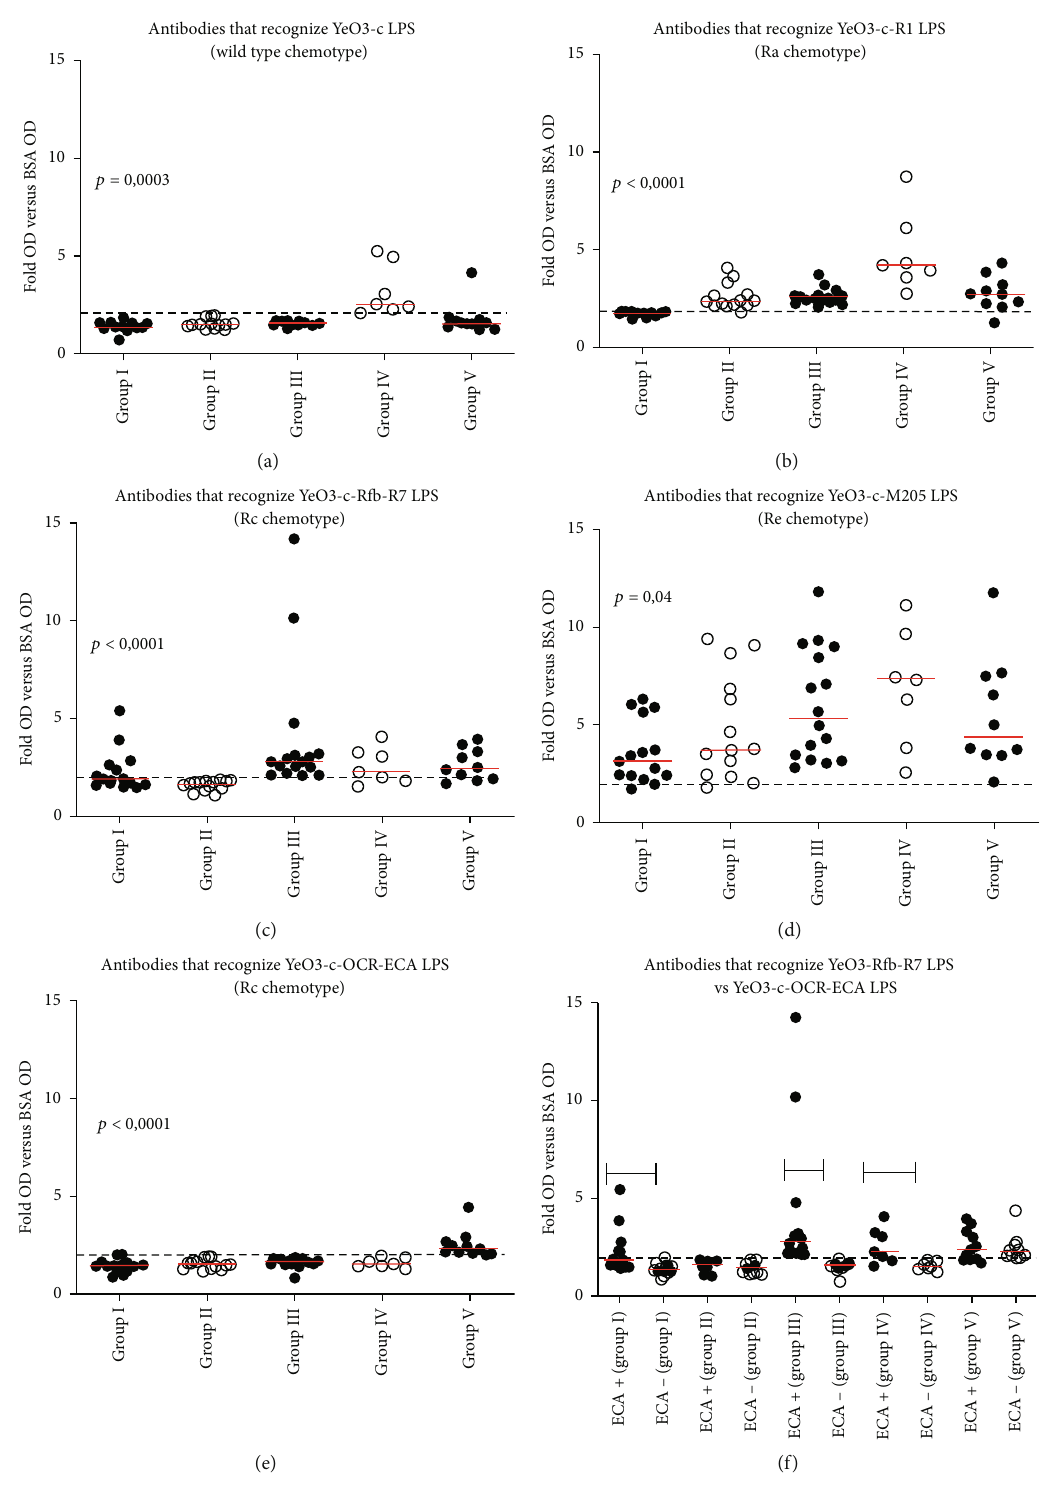
Figure 3: Reactivity of synovial fl uid antibodies with LPSs: YeO3-c (wild-type chemotype) (a), YeO3-c-R1 (Ra chemotype) (b), YeO3-c-Rfb- R7 (Rc chemotype) (c), YeO3-c-M205 (Re chemotype) (d), and YeO3-c-OCR-ECA (Rc chemotype without ECA) (e) in groups I-V. Comparison of the levels of ECA-dependent (YeO3-c-Rfb-R7, ECA+) and ECA-independent (YeO3-c-OCR-ECA, ECA-) antibodies between groups (f). Red bars represent median values. One-way ANOVA or Mann – Whitney U test was used for statistical analysis. Horizontal black lines show the statistically signi fi cant di ff erences between the analyzed groups ( p < 0 : 05 , see details within the text), while one-way ANOVA results are given when signi fi